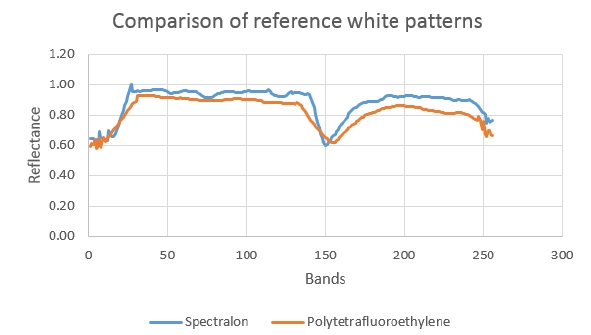
Figure 14. Spectral signature of the mudwall of the Torre del Horno according to the reference patterns: spectralon and polytetrafluoroethylene as reference white and polycarbonate as reference black in both